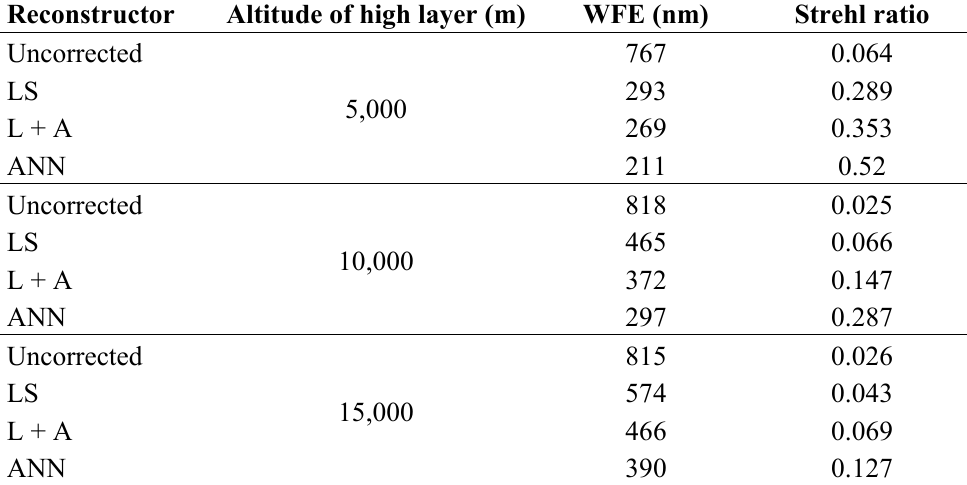
Table 5. Wave-front Error and Strehl ratio for the three reconstruction at extreme test cases with increasing